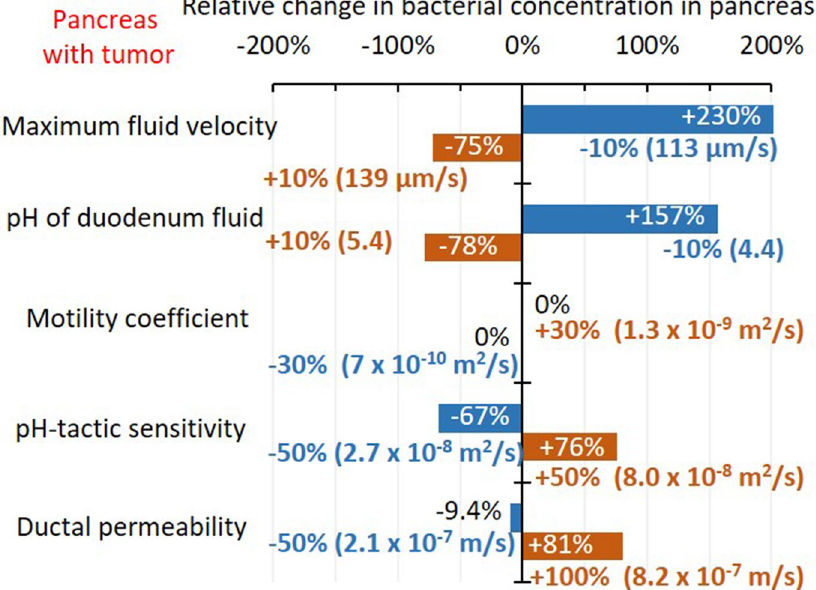
Figure 5. Parametric sensitivity analysis for bacterial migration from the duodenum into the pancreas with tumors. The changes in simulated bacterial concentration in pancreas are shown with each parameter